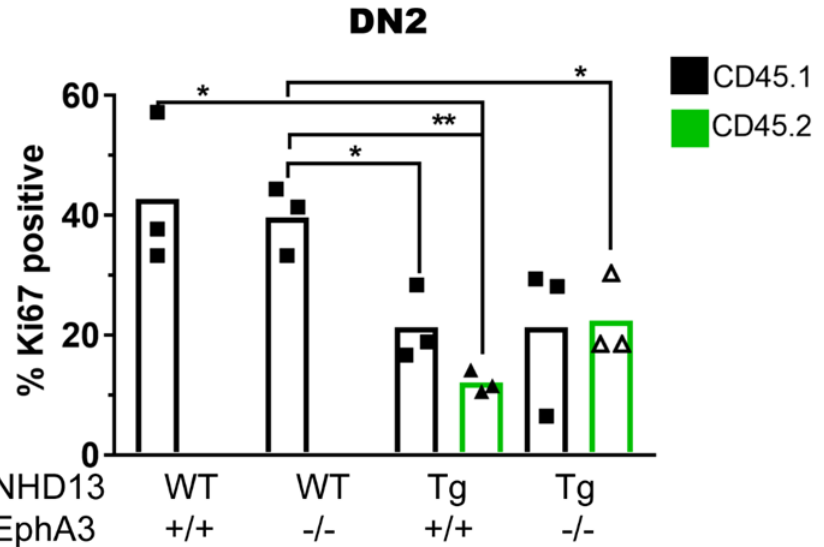
Figure 6. Cell division arrest of WT thymocytes by NHD13 thymocytes. Cell division analysis of DN2 (DN2A and DN2B) thymocytes in the primary transplant recipient. DN2 (CD44 + , CD25 + ) recipient (CD45.1) or donor (CD45.2) thymocytes were analysed for cell division/quiescent status using Ki67 and DNA (Hoechst) stains. Bars represent the mean, points represent 3 individual mice per group, and p- values were calculated using Student’s t -test (* p < 0.05, ** p < 0.005).